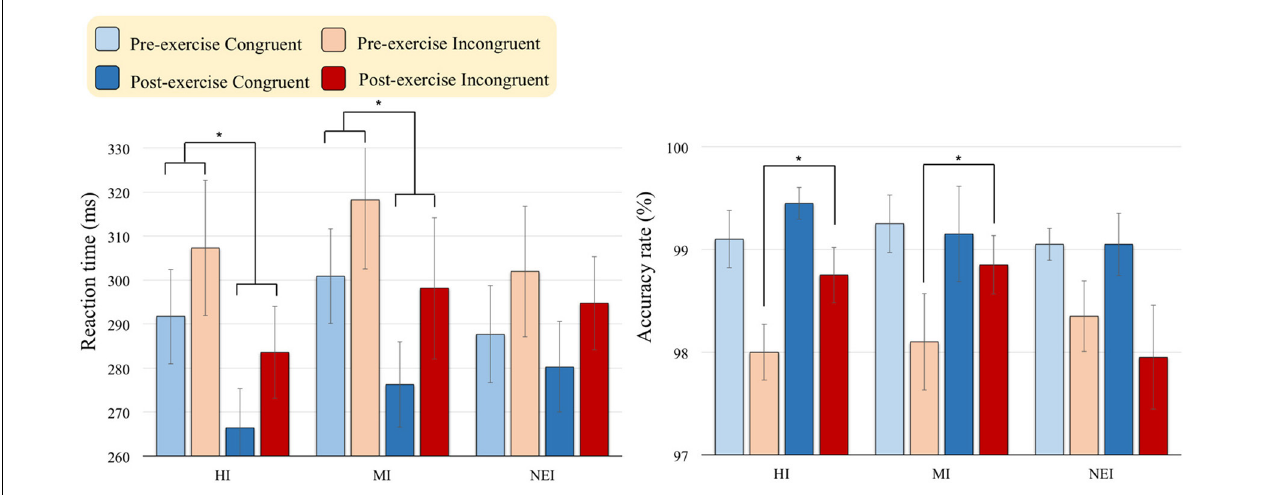
FIGURE 1 | Behavioral [RTs (ms) in Go conditions; Accuracy rate (%) in No-Go conditions] performance (Mean ± SD ) for the two exercise intervention groups (i.e., HI: high-intensity and MI: